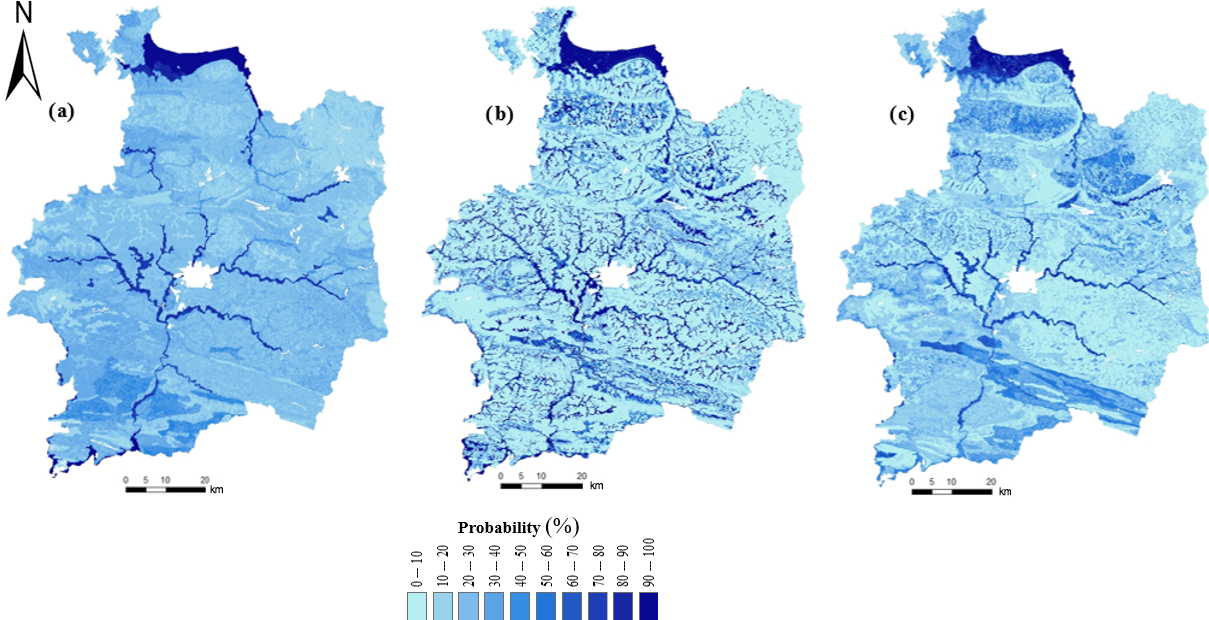
Figure 4. Global probability of hydromorphic soils over the study area derived from (a) original DSMART, (b) DSMART with soil landscape relationships and (c) DSMART with extra soil observations. The probabilities of the three STUs with the highest prediction occurrence are summed if they are